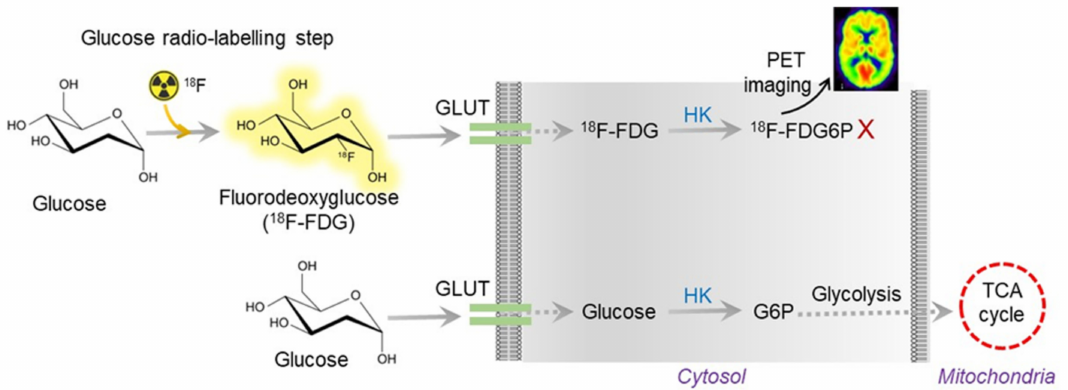
Figure 2. Overview of 18F-FDG PET working mechanism. The radioactive FDG is converted to FDG6P, which can be measured and quantified by PET imaging. In AD, the glucose uptake is vastly reduced due to insulin resistance. Thus, the radioactive tracer does not show up in AD brain